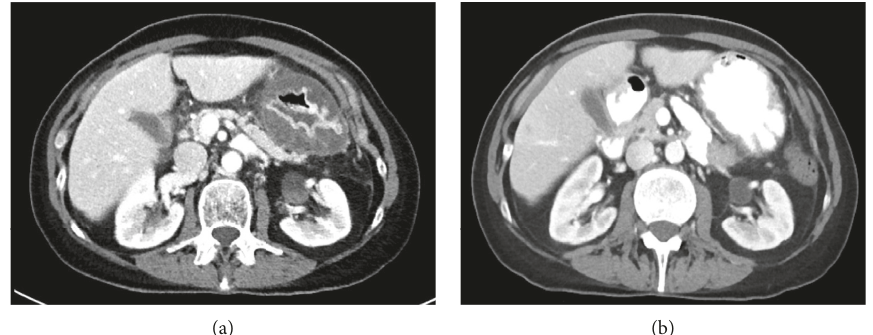
Figure 1: (a) Diffuse thickening of the stomach wall with mucosal hyperenhancement and marked submucosal edema. (b) Marked interval improvement in gastric wall thickening and greater curvature intramural hypodensity after two weeks of antibiotic treatment.